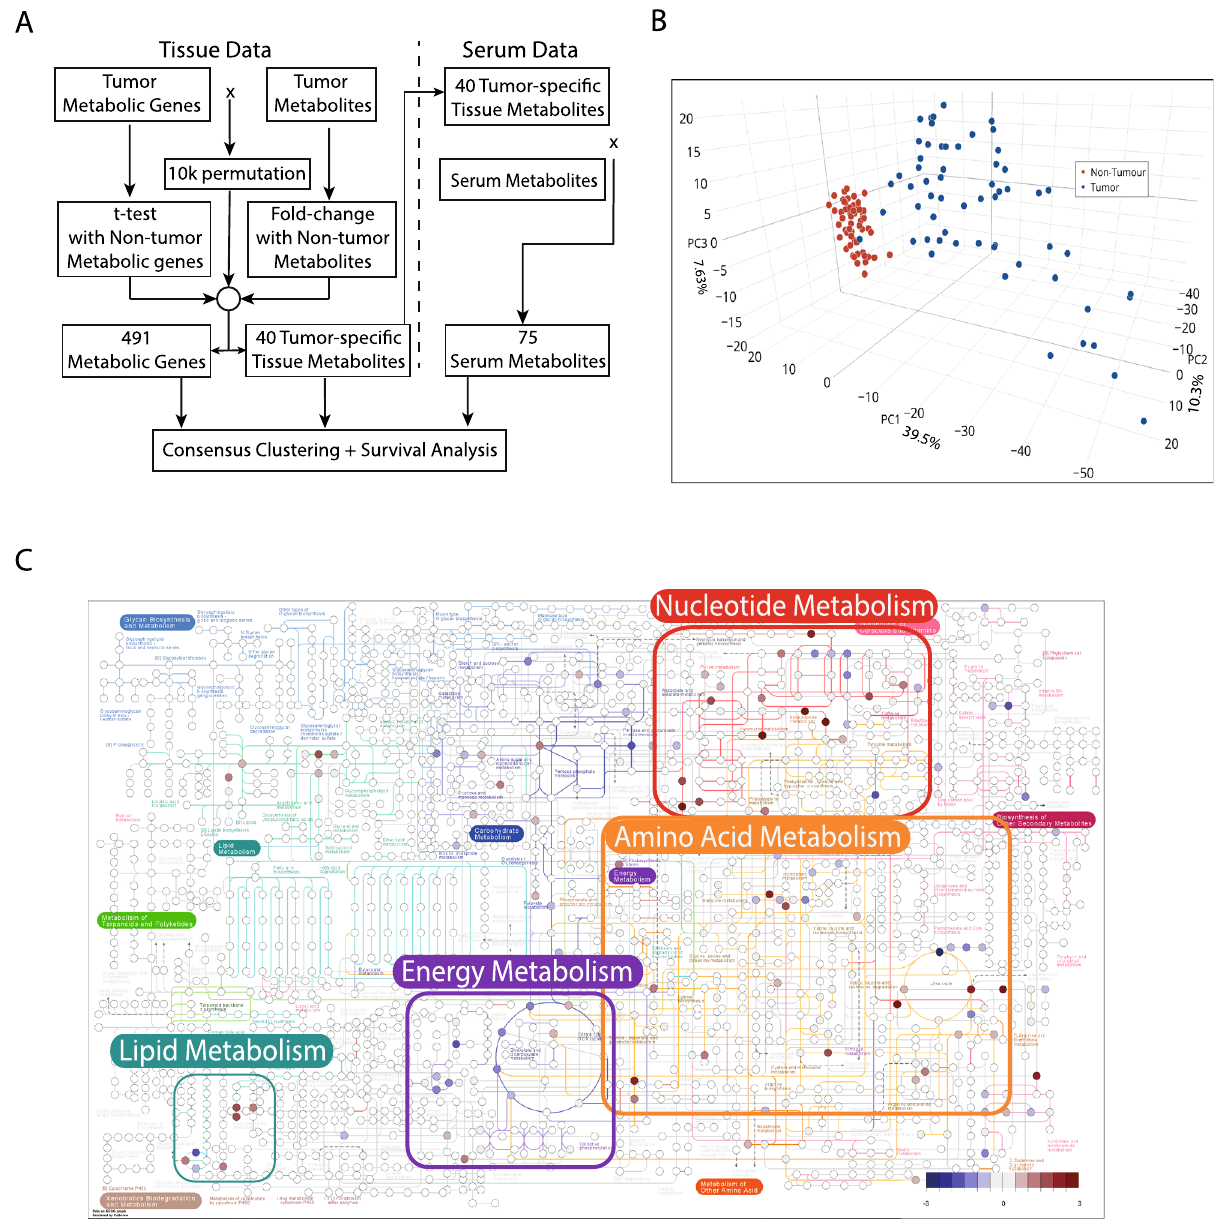
Figure 1. Overall study design, tissue stratification by metabolite abundance and their related pathways. ( A ) Overall flowchart of the analysis. ( B ) 3D PCA plot of tumor and adjacent non-tumor tissue metabolites from Thai HCC patients based on expression of 500 most variable metabolites. The tumor and non-tumor tissues can be clearly separated by tissue metabolites alone. ( C ) KEGG Overall Human Pathways (map accession number hsa01100 15 ) overlaid with metabolite ratios between tumor and adjacent non-tumor tissues from HCC patients. Each node represents a human metabolite in a metabolic pathway. The colors represent log2 fold-change of the tissue metabolites. Blue represents increased mean metabolite abundance from adjacent non-tumor tissues, and red represents higher mean metabolite abundance from tumor tissues. White nodes represent metabolites with no data available. Abbreviations: PCA—Principal Component Analysis; HCC—Hepatocellular